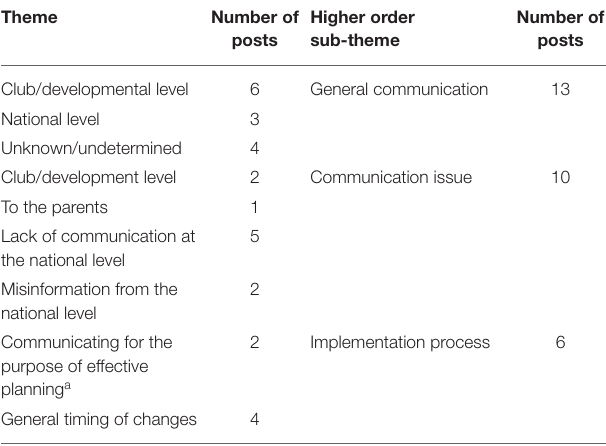
TABLE 5 | Category: communication regarding the policy